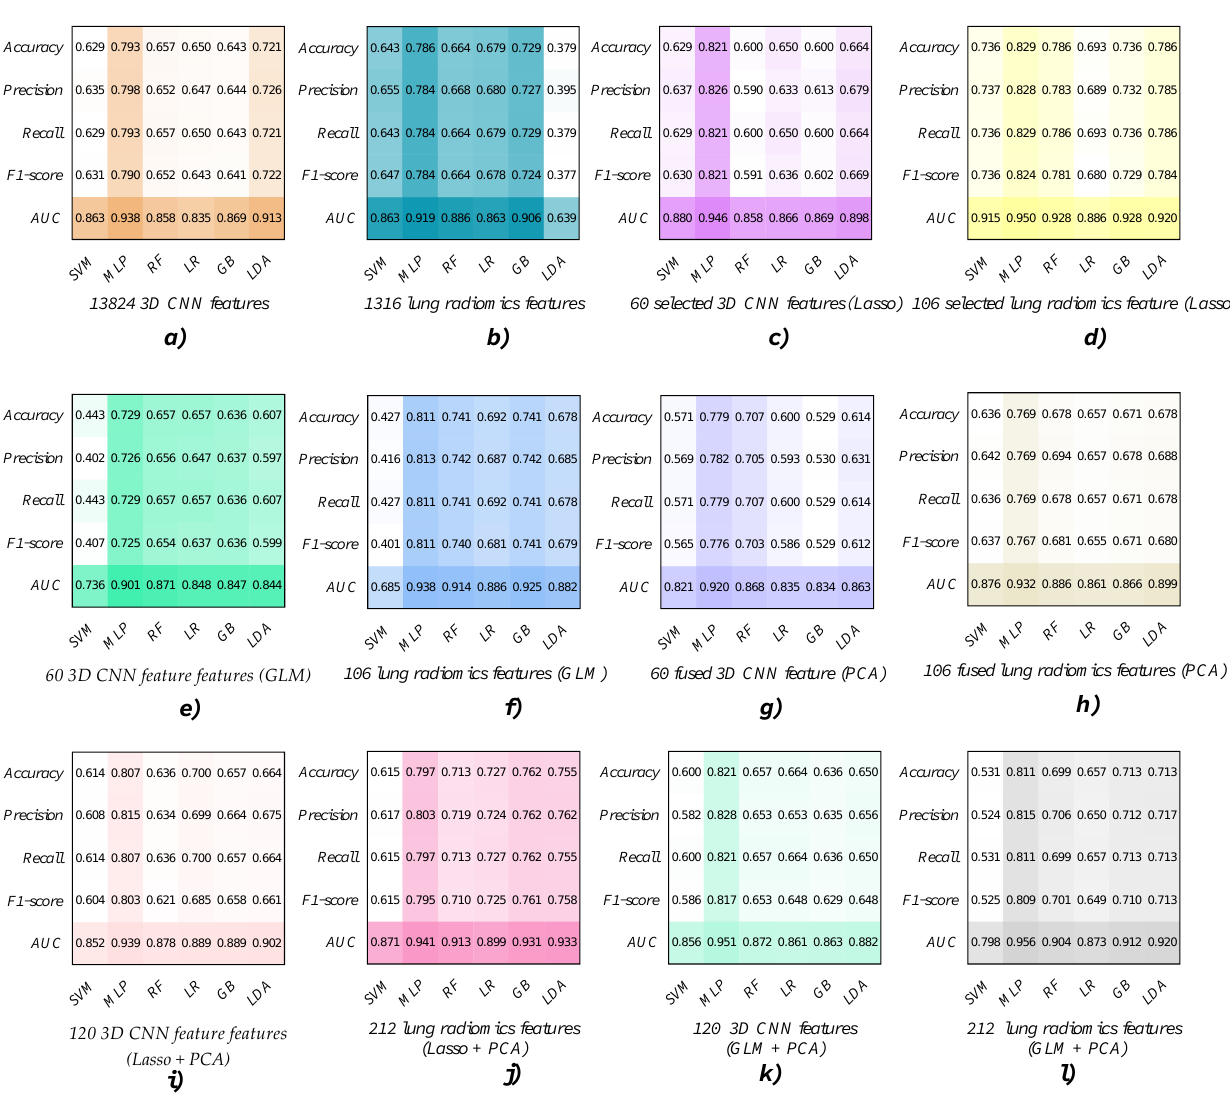
Figure 4. Visual evaluation metrics of different ML classifiers with different features in Experiment 1. ( a , b ) The evaluation metrics of different ML classifiers with 13,824 original 3D CNN/1316 original lung radiomics features. ( c – h ) The evaluation metrics of different ML classifiers with 60 3D CNN/106 lung radiomics features separately selected or fused by the Lasso algorithm, GLM, and PCA algorithm. ( i – l ) The evaluation metrics of different ML classifiers with different combinations of feature vectors of the selected and fused lung radiomics features or the selected and fused 3D CNN features.